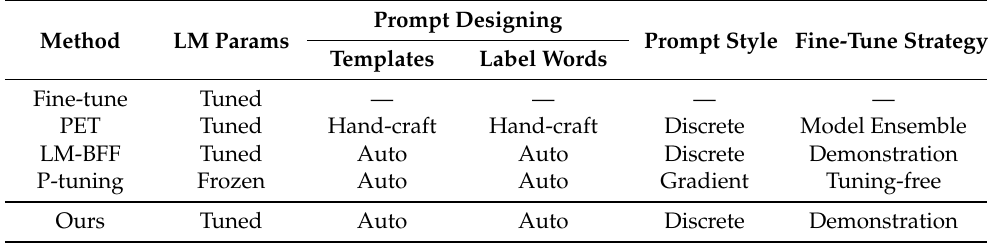
Table 2. An organization of baselines.